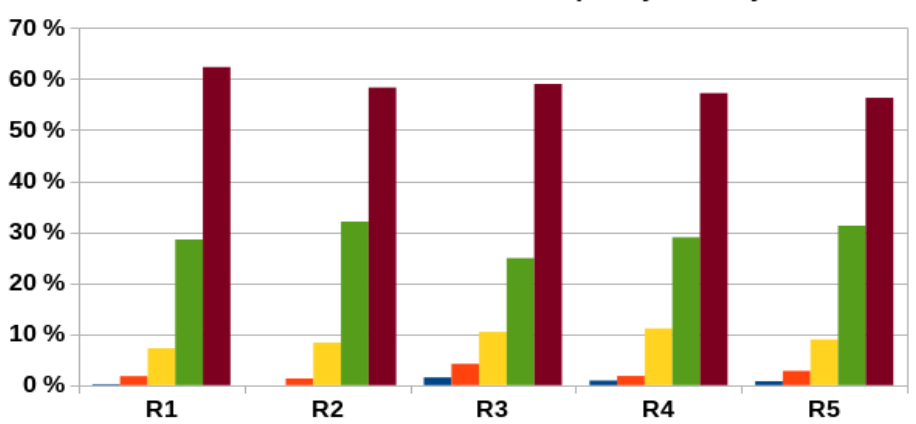
Figure 1. Percentage of responses based on year of residency (R, residency).